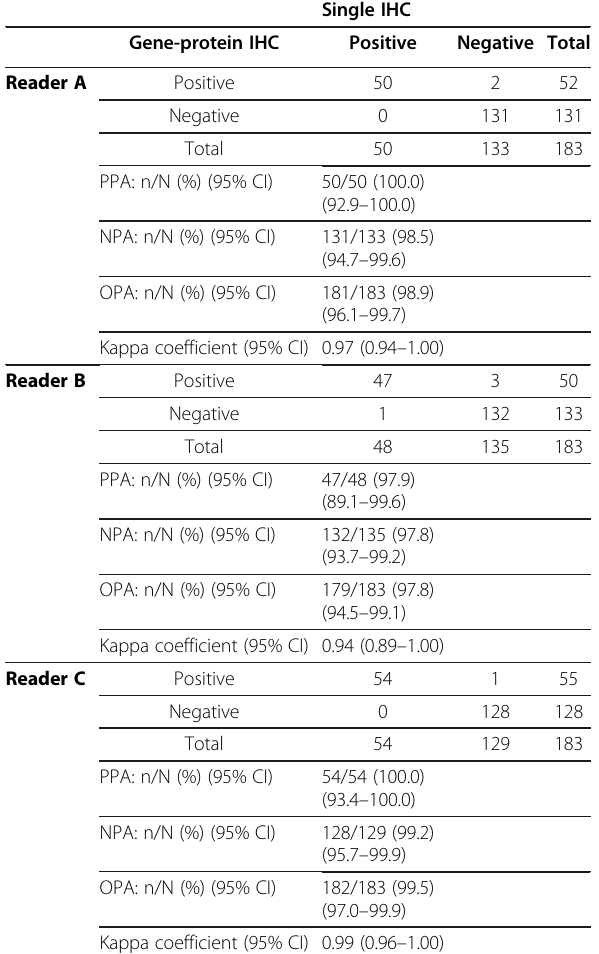
Table 6 Gene-protein BISH (comparator) vs. single BISH (reference) agreement